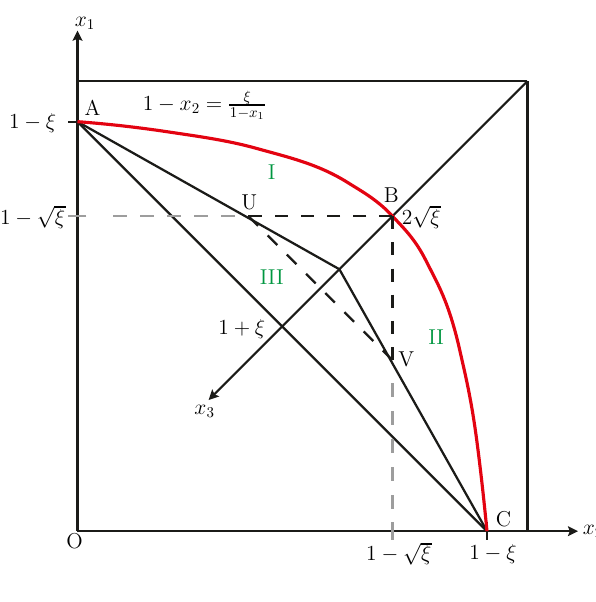
Figure 1 . Dalitz plot showing phase space for γ → q ¯ qg with off-shell gluon. The energy momentum conservation condition x 1 + x 2 + x 3 = 2 is satisfied throughout this x 1 − x 2 plane and the actual √ length along x 3 axis is 2 times the measured length. The collinear limit (when the gluon is collinear to the quark) corresponds to x 1 = 1 − ξ , x 2 = 0 , while the soft limit (when the gluon √ is soft to the quark) corresponds to x 1 = x 2 = 1 − ξ . The soft boundary of the phase space 1 − x 2 = ξ/ (1 − x 1 ) is denoted by the red